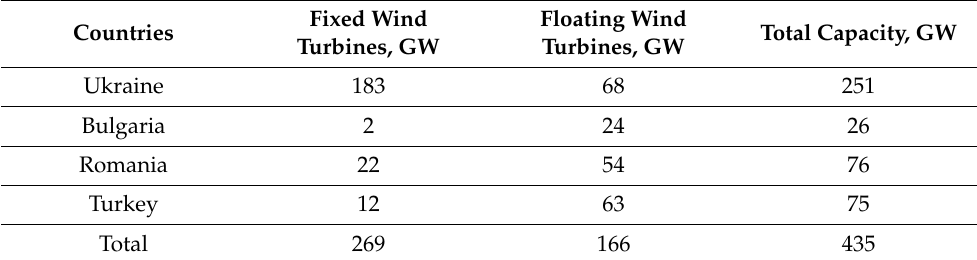
Table 3. Offshore wind potential in the Black Sea [80]. Countries